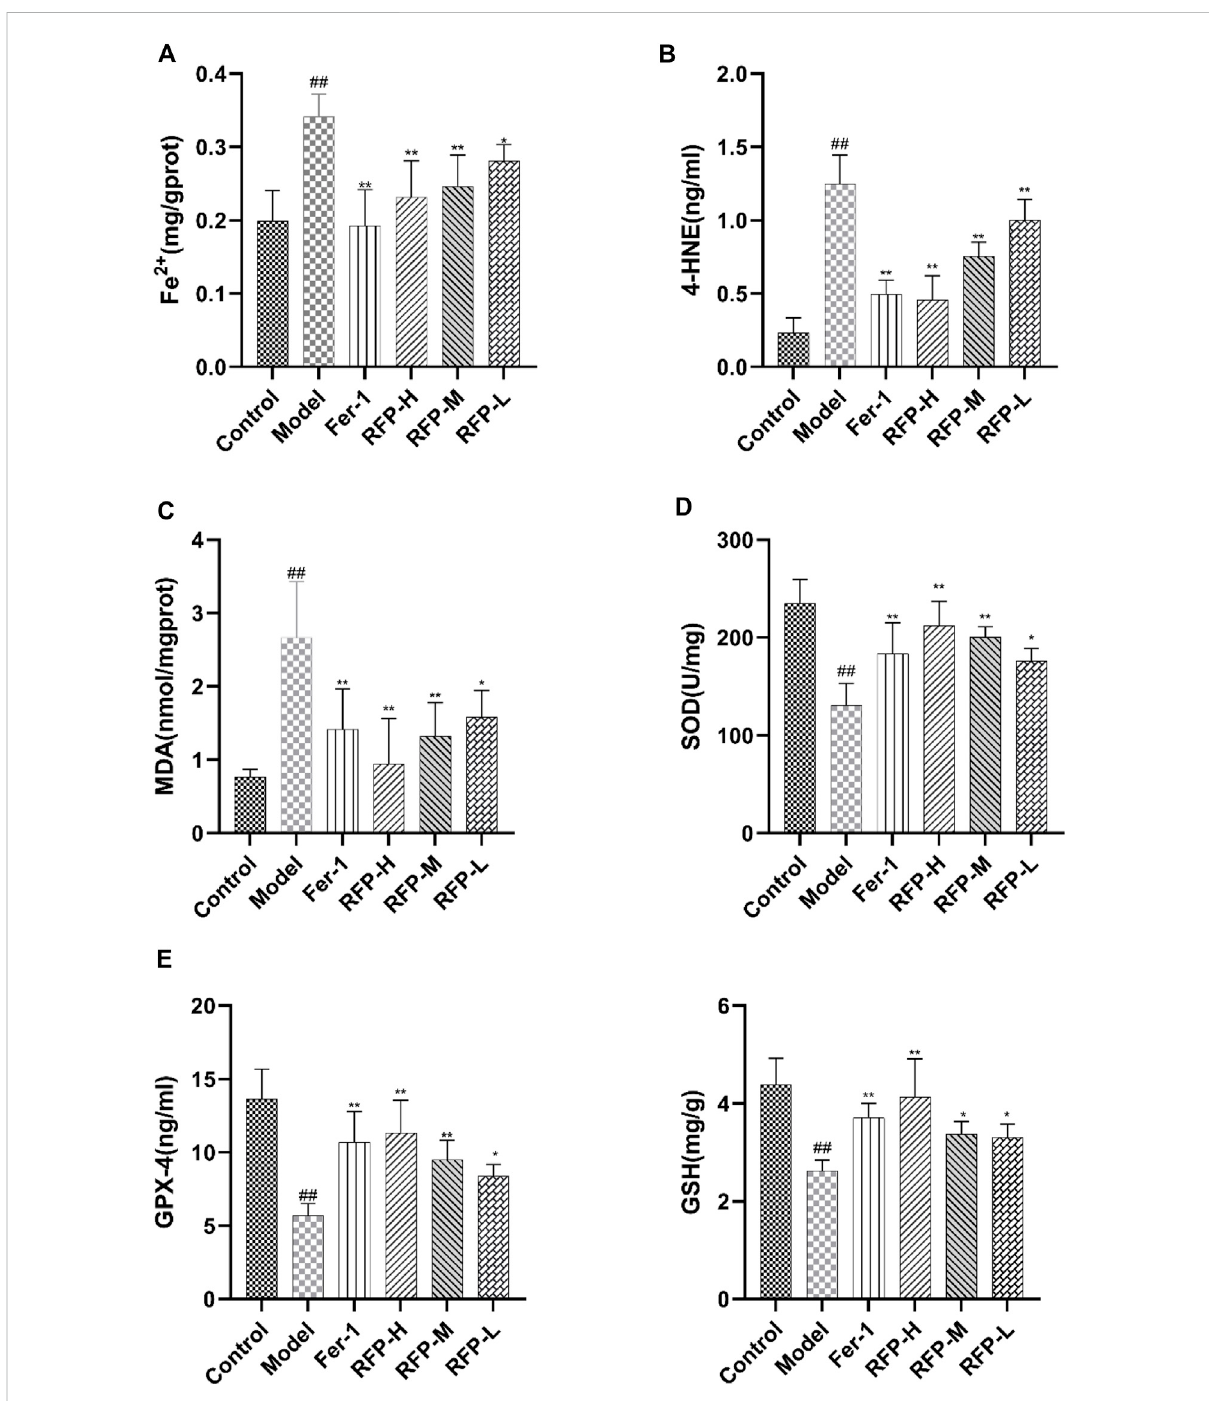
FIGURE 13 Effect of RFP on the content of six biochemical indicators in renal tissue homogenates of mice with cisplatin-induced acute kidney injury. (A) Levelsoffreeferrousionscontentinrenaltissue. (B) Levelsof4-HNEinrenaltissue. (C) LevelsofMDAinrenaltissue. (D) LevelsofSODinrenaltissue. (E) Levels of GPX-4 in renal tissue. (F) Levels of GSH in renal tissue. Data are expressedas mean ± SD (n = 8), * p < 0.05, ** p < 0.01as compared to the model group, ## p < 0.01 as compared to the blank